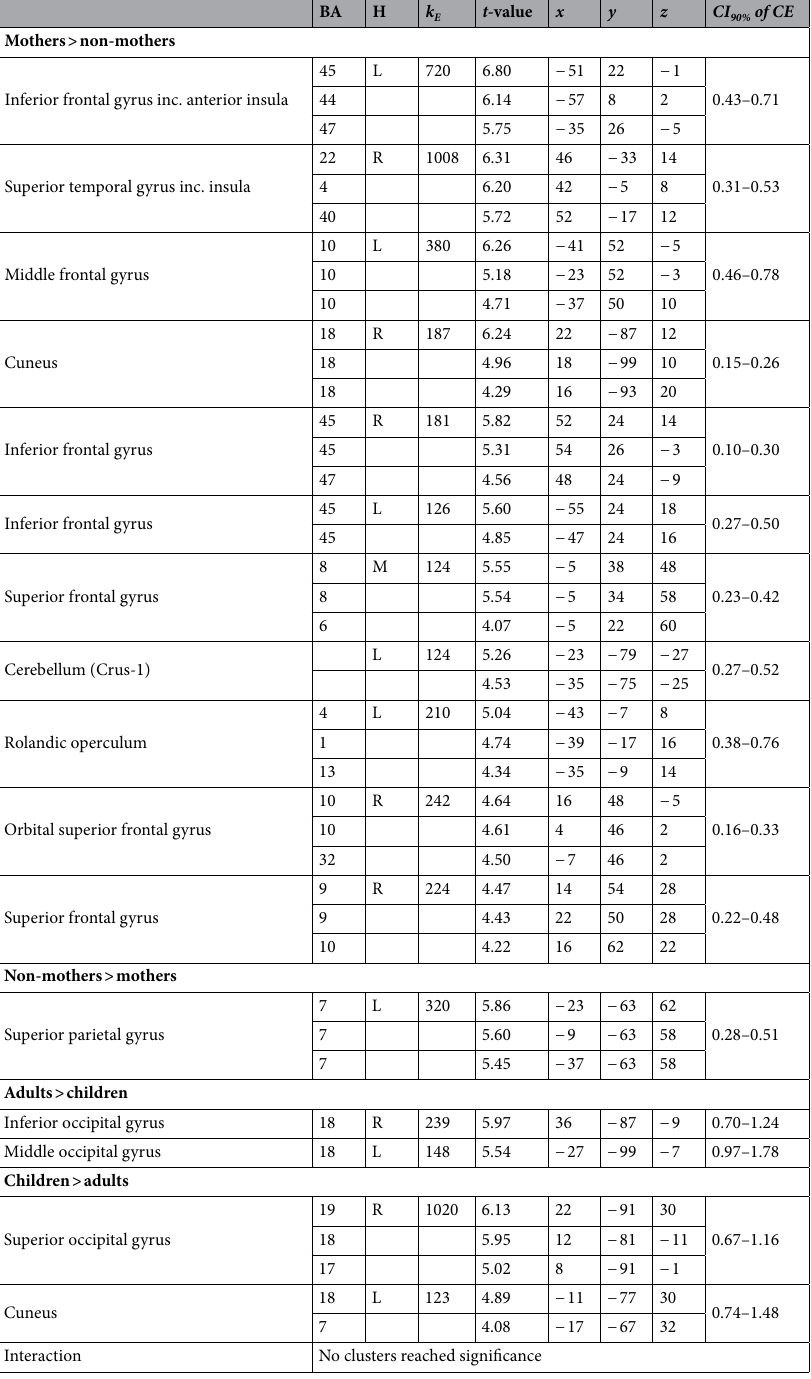
Table 2. Results of the whole-brain analysis based on the flexible factorial model. All contrasts are t-contrasts based on the flexible factorial model. All contrasts are t-contrasts based on differential first-level contrast images of “painful > neutral” scenarios. Cluster-corrected p FWE < 0.05; all results are grey matter masked; L left, R right, M medial, k E cluster size, CE cluster estimate (90% confidence interval), coordinates are in MNI space and are the location of the peak voxel for each